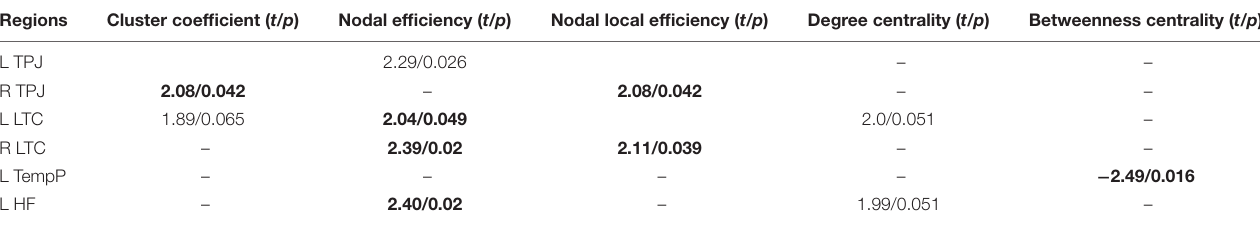
R, right hemisphere; L, left hemisphere; TPJ, temporal parietal junction; LTC, lateral temporal cortex; TempP, temporal pole; HF, hippocampal formation. Significant correlation results were marked in